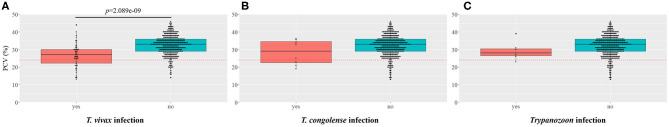
Comparison of packed cell volume (PCV) between Trypanosoma spp.-infected and non-infected cattle. The boxplot shows the comparison of the PCV between (A)
T. vivax, (B)
T. congolense, (C)
Trypanozoon-positive and negative cattle samples (confirmed by ITS1 PCR). Statistical significance was assessed by Wilcoxon rank sum-test (p < 0.05).